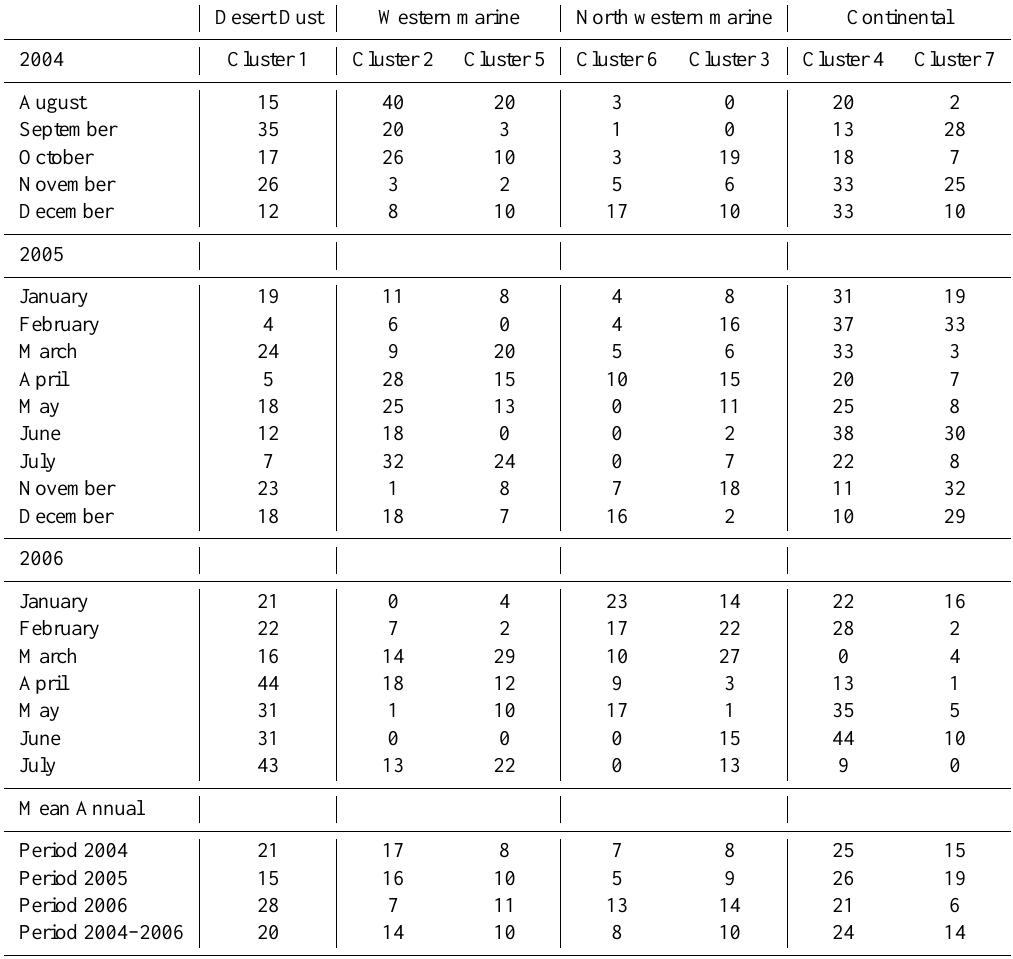
Table 3. Monthly relative frequencies in percentages of air masses at 500m according to the clustering algorithm during the 498 days under synoptic-scale pattern. Centroids of the cluster classification at 500m are identified in Fig.